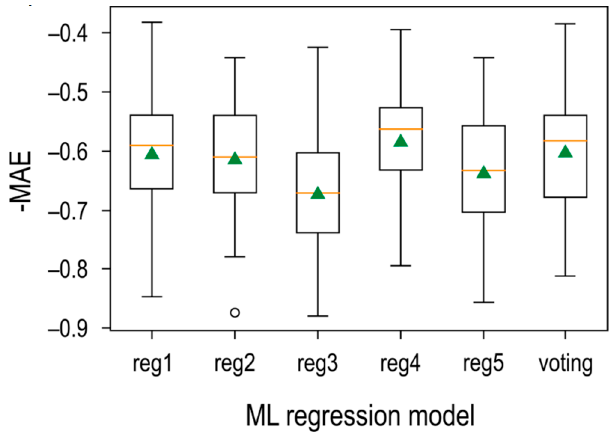
Figure 10. Boxplots of halloysite ML model evaluation.